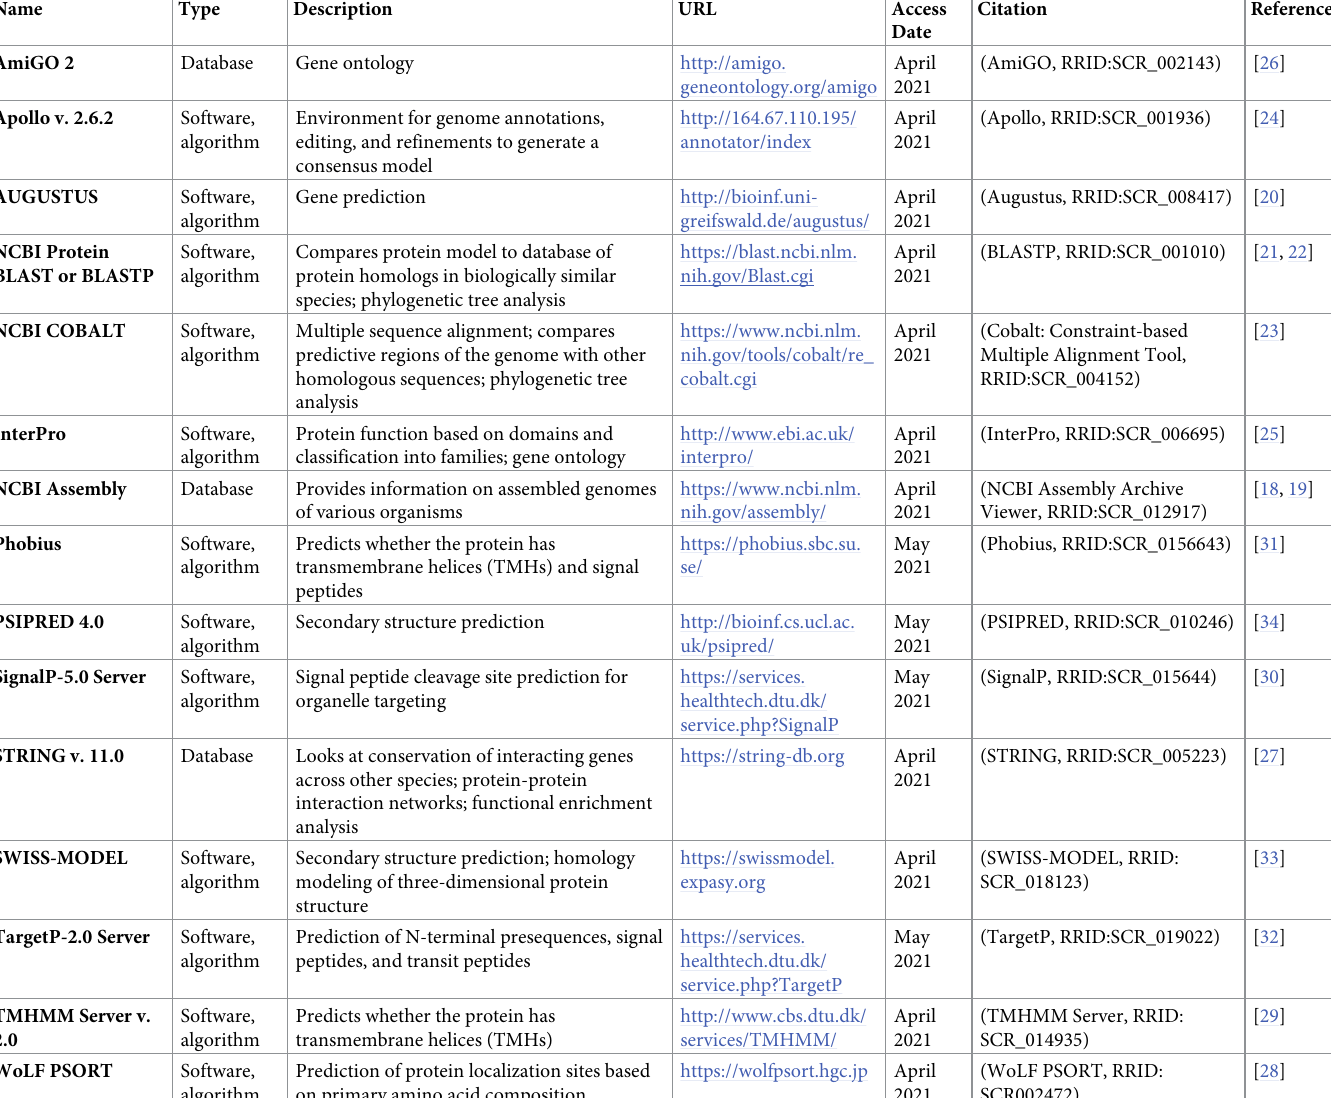
Table 1. Summary table of 15 computational biology tools used to study the conservation, structure, function, localization, and phylogeny of genes within the E . subglobosa